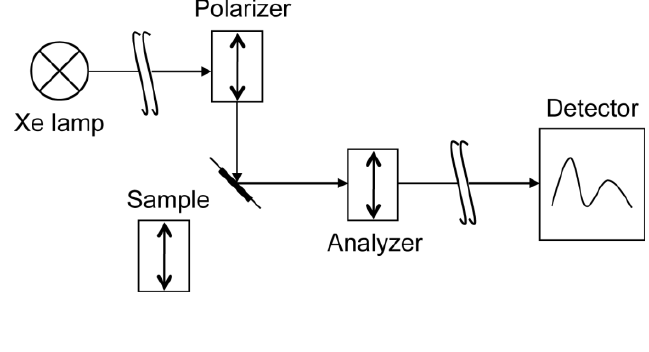
Figure 8. Optical train used for the photoluminescence experiments. The polarizer was placed behind the excitation shutter into the light path, and the analyzer was placed in front of the emission shutter, where the arrows indicate the polarizing and analyzing directions. Although the picture shows a parallel direction of the arrows, the polarizer and analyzer both could be